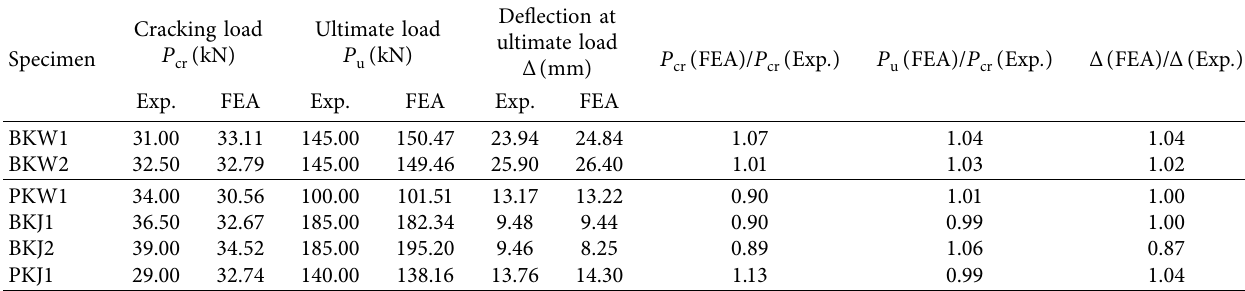
Table 4: Cracking moment and maximum moment of